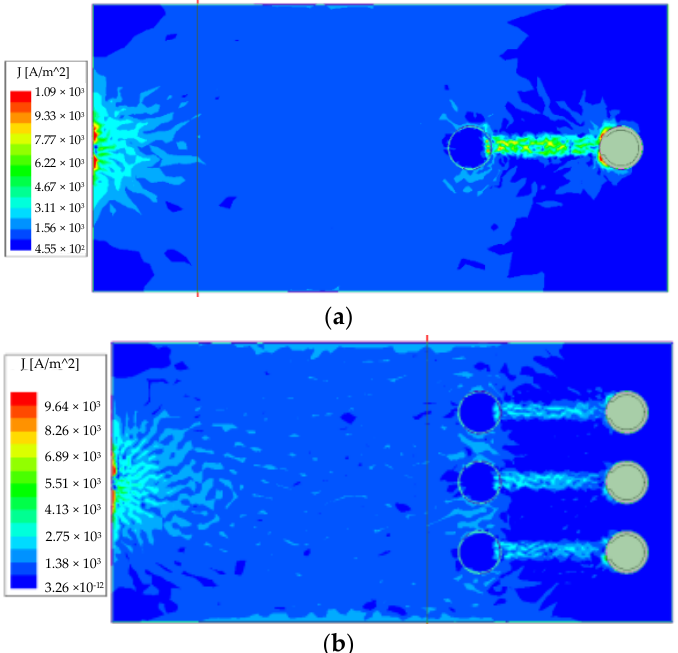
Figure 10. Current distribution diagram of multi-bus capacitor parallel laminated busbar. ( a ) Single bus capacitor. ( b ) Three bus capacitors.